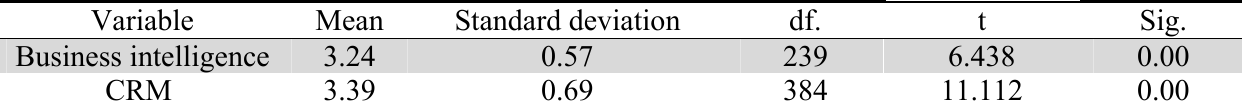
The results of t-student test Variable